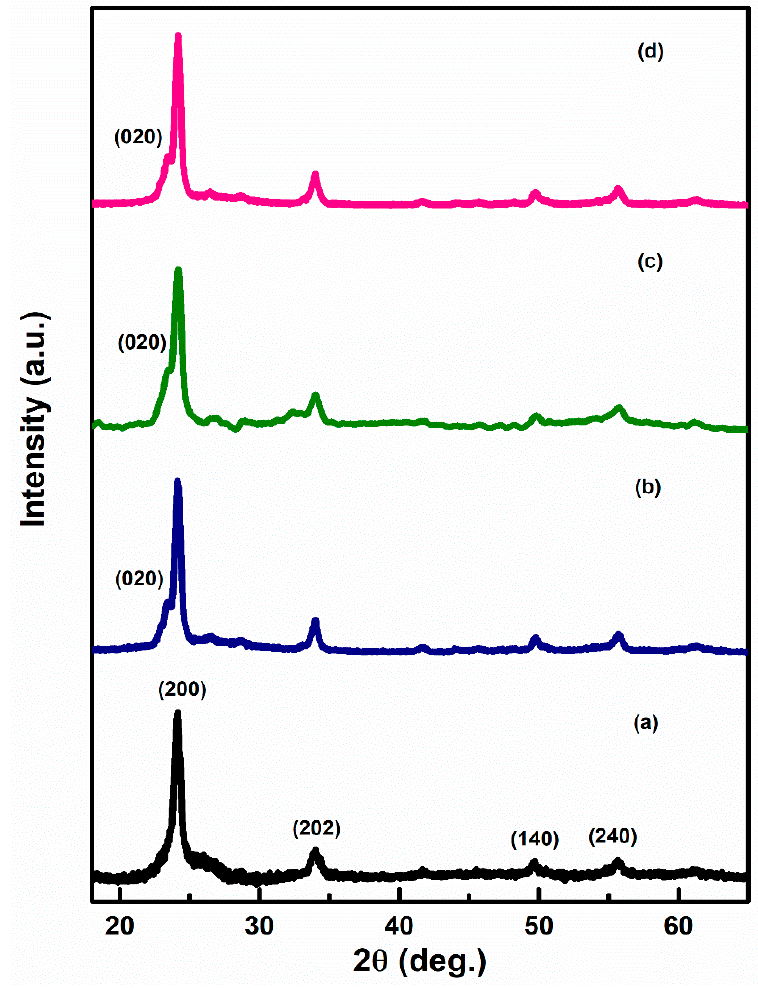
Figure 2. XRD pattern of ( a ) 0%, ( b ) 1%, ( c ) 3%, and ( d ) 5%, Ag–WO 3 films. Table 1. Structural and morphological parameters of Ag–WO 3